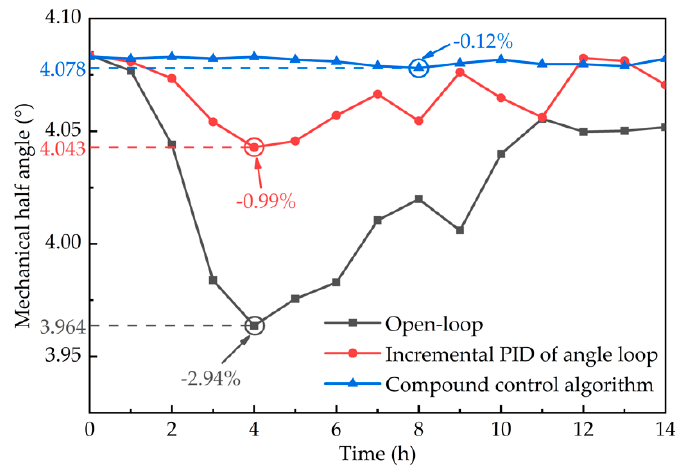
Figure 15. Comparison of long-term stabilities for the scanning micrograting operated with different control systems.